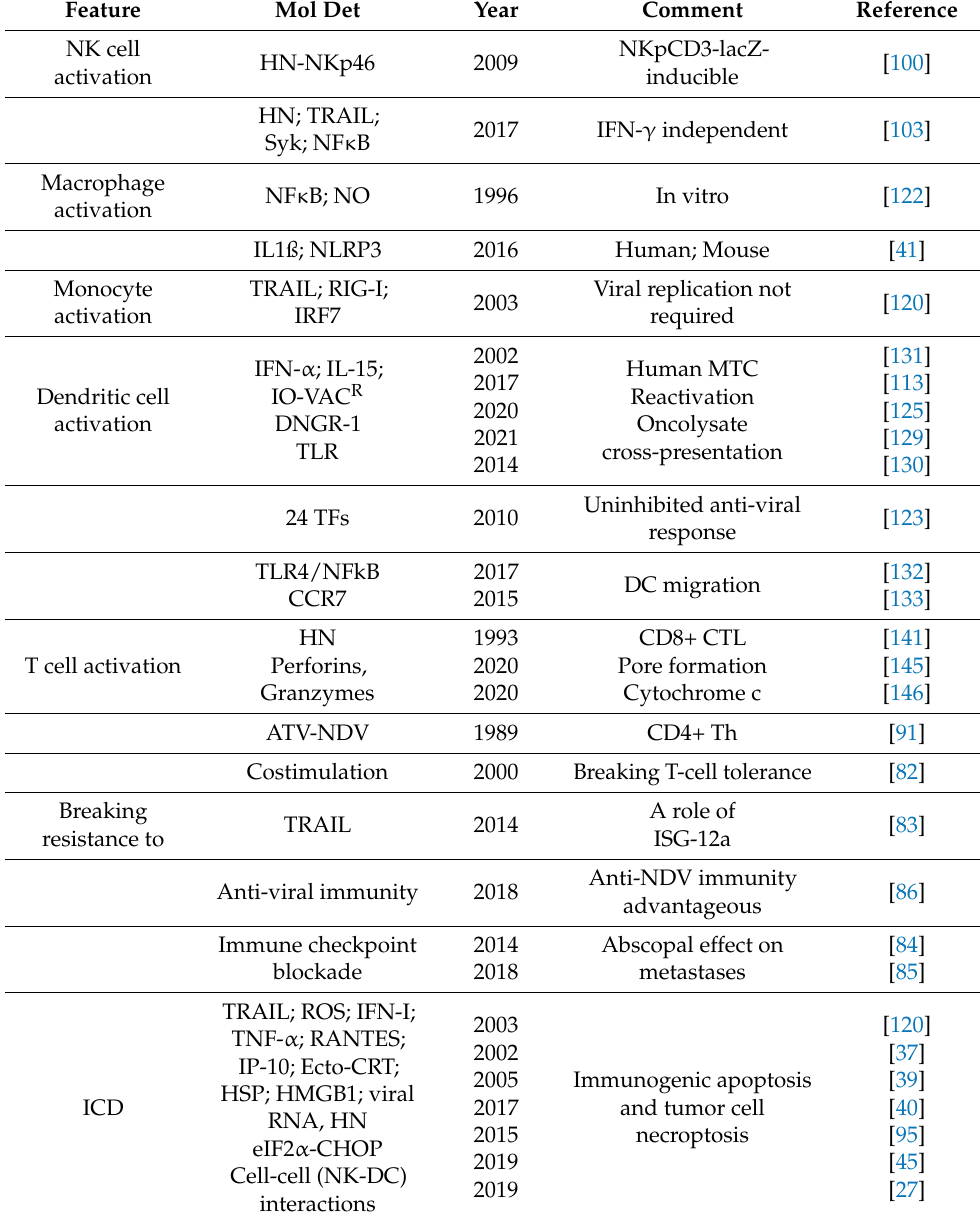
Table 2. NDV mediated immune cell